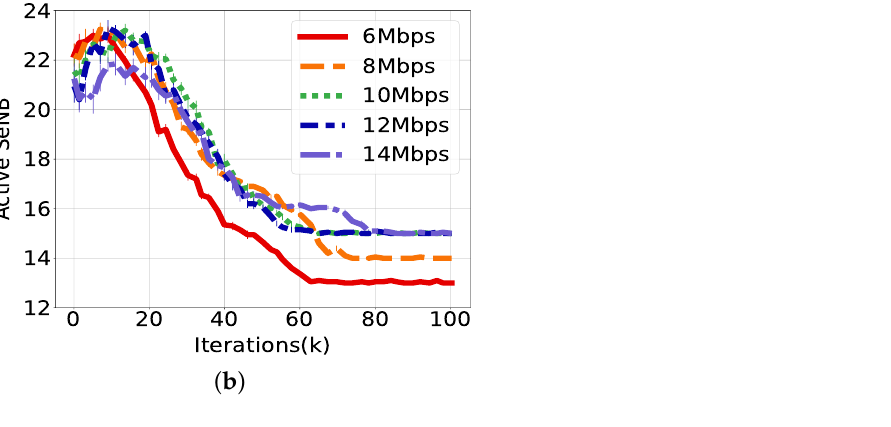
Figure 6. Performance evaluation of PDOLS according to UE’s demand rate. ( a ) Average data rate per UE. ( b ) Number of active